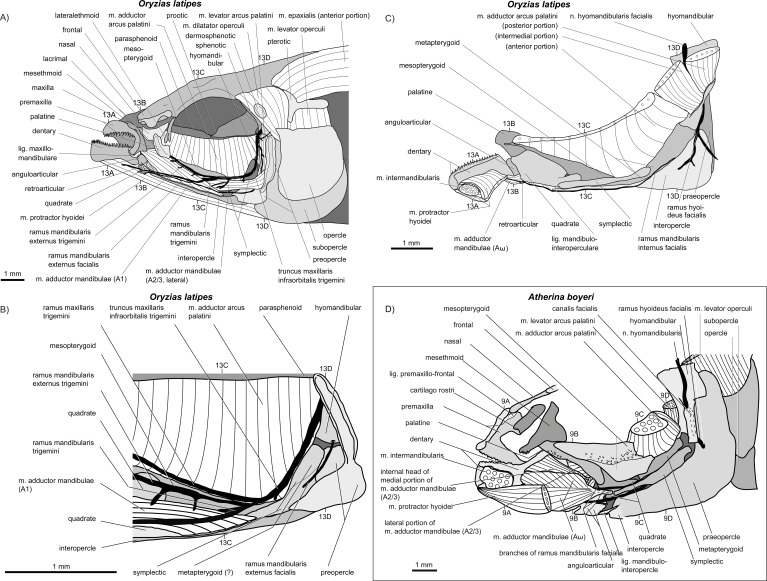
Manual dissections.(A–C) Oryzias latipes; levels of histological sections (Fig. 13) are indicated. (A) and (C) modified from Werneburg & Hertwig (2009). Compare to Fig. 2E. (D) Atherina boyeri; for other dissections of this species see Fig. 8, for histological sections see Fig. 9. Compare to Fig. 2C.